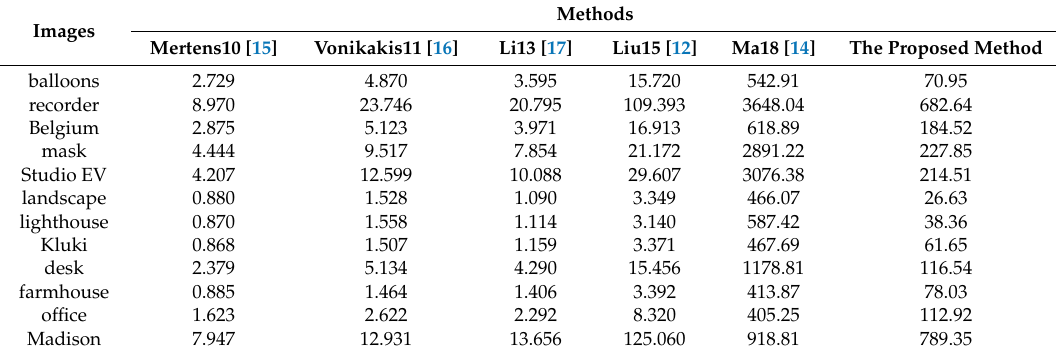
Table 4. Computational efficiency of different fused methods on the 12 image sequences